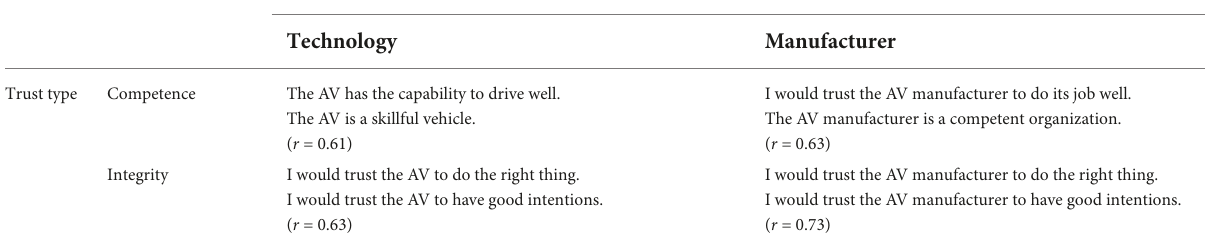
TABLE 2 Measures used to assess competence and integrity in autonomous vehicle (AV) technology and manufacturers.